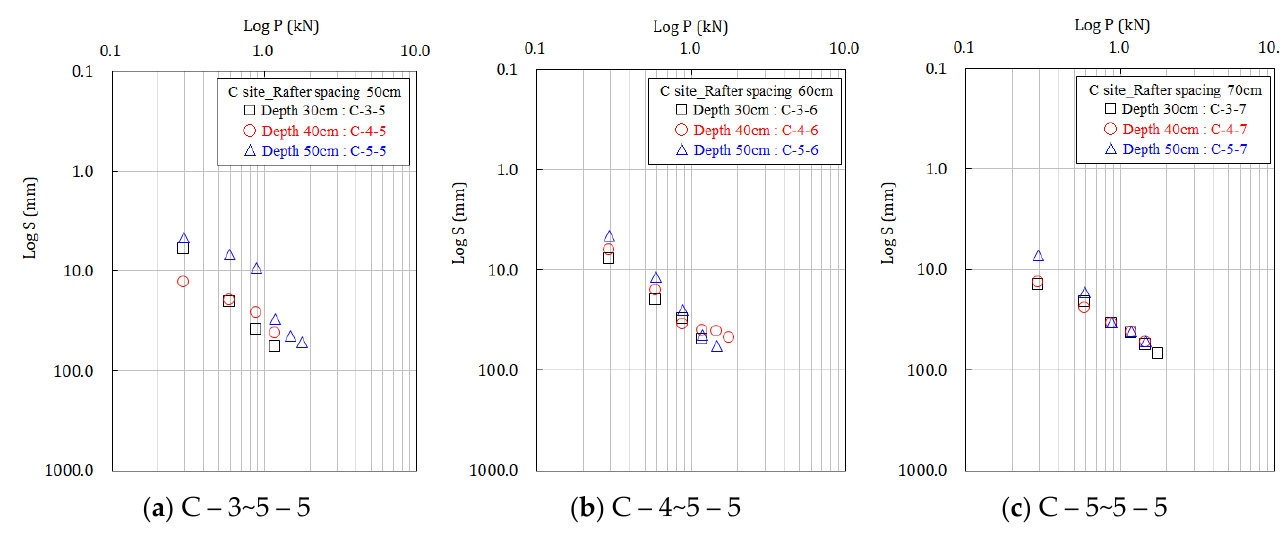
Figure 11. Results of field uplift resistance on site C.